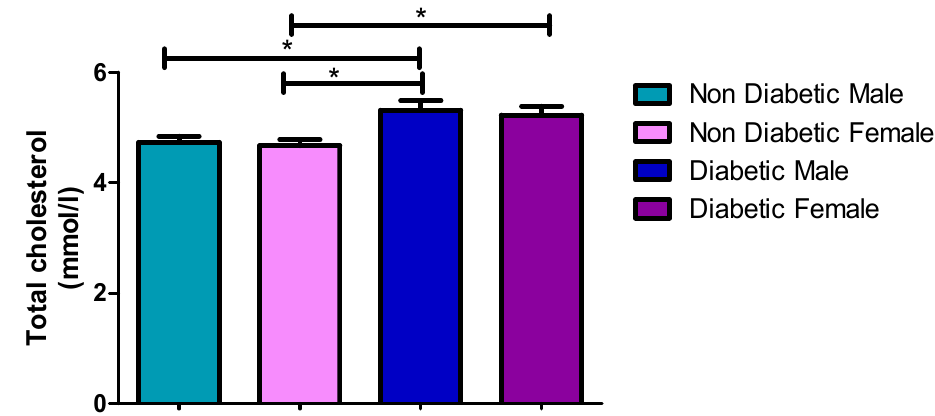
Figure 2. Total cholesterol concentration. *, a significant statistical difference ( p -value < 0.05 ). The statistical bar ( ) shows the relationship between the four variables: there was a significant statistical difference in the total cholesterol concentration between the non-diabetic female and diabetic female, the non-diabetic male and diabetic male, and between the non-diabetic female and diabetic male, respectively.